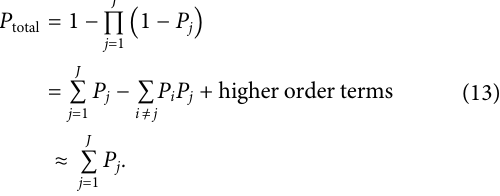
Frontiers in Earth Science |